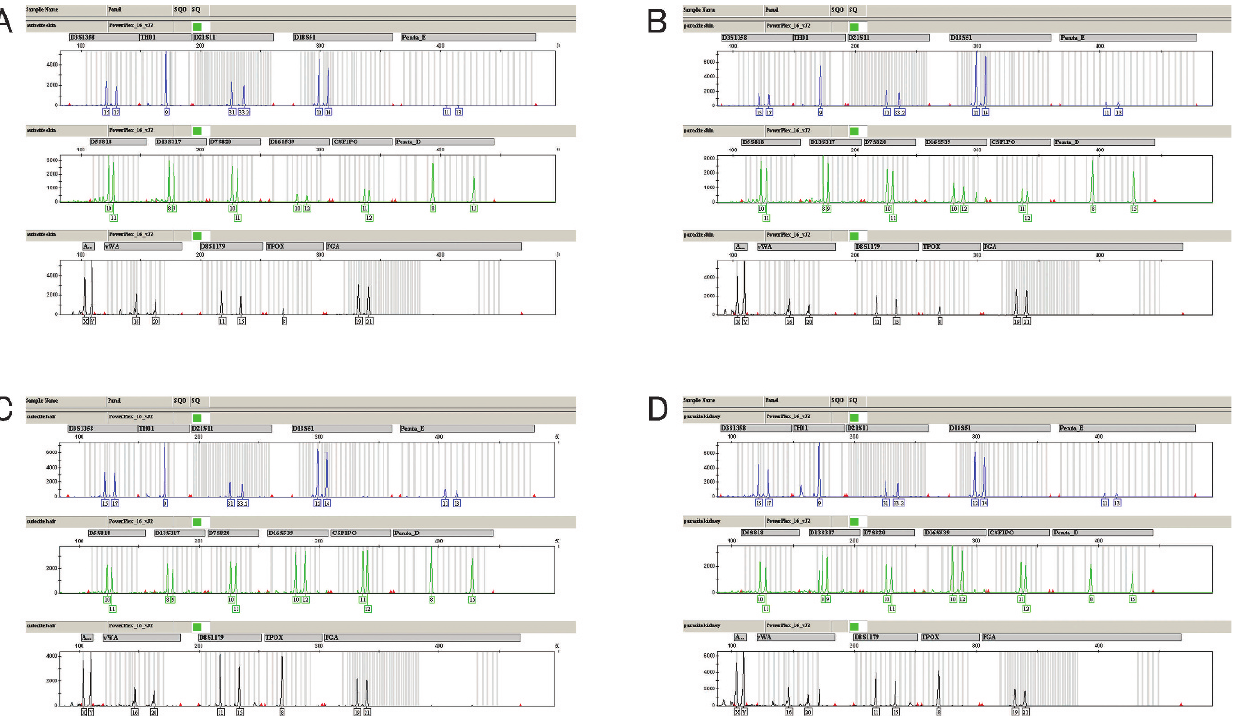
Figure 3 - Case 2. Results of the DNA analysis of the twins in case 2. (A) Skin from the autosite. (B) Skin from the parasite. (C) Hair from the autosite. (D) Kidney from